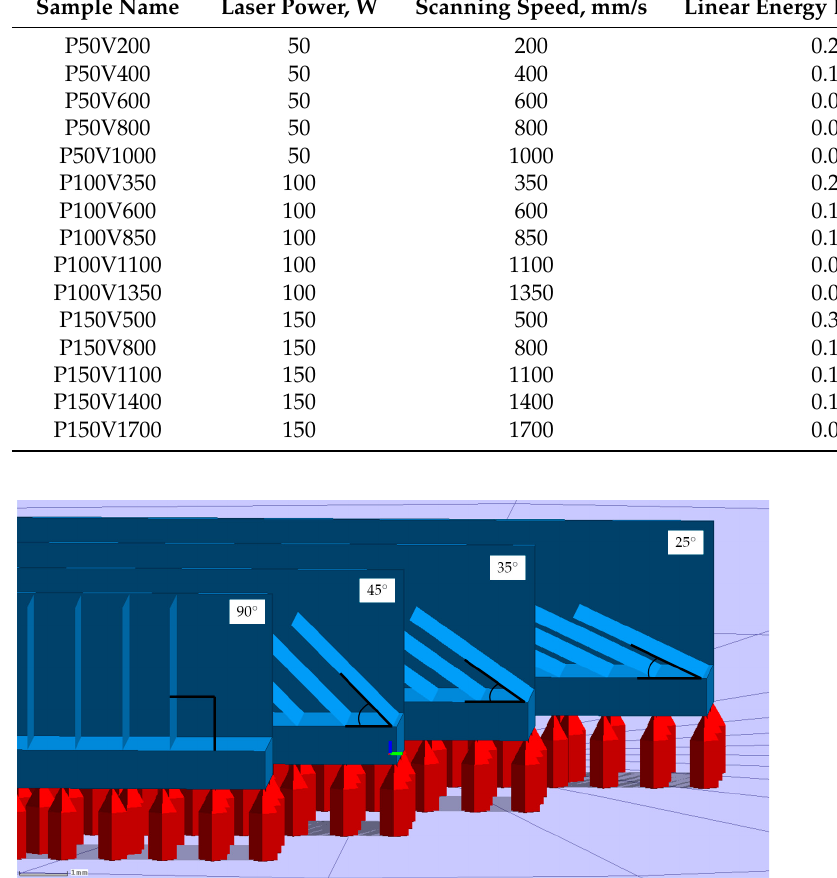
Figure 1. The samples of thin walls in Gliser software. Table 1. The window of process parameters used for the optimization procedure.